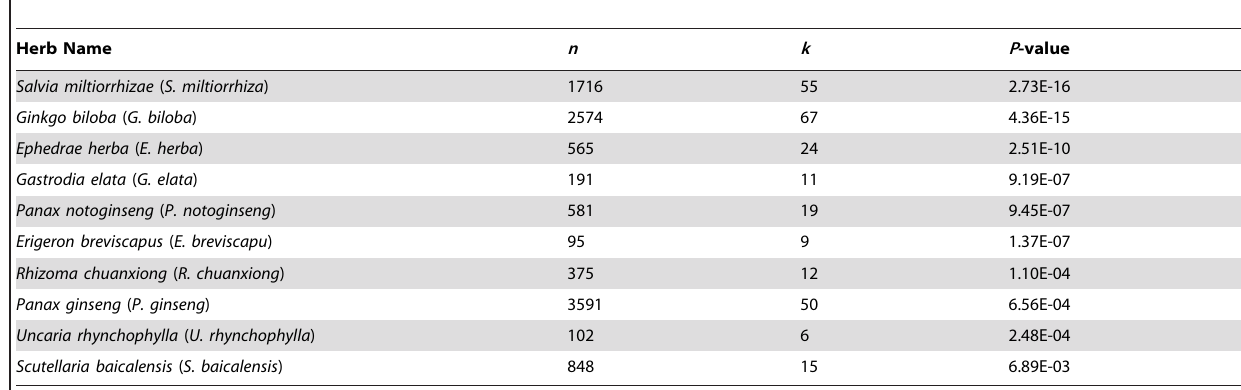
Table 1. Statistics and association analysis between herbs and